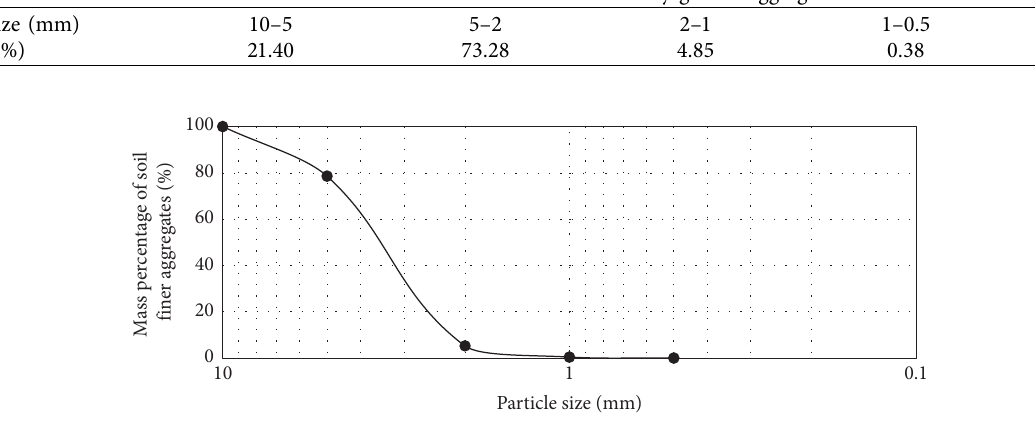
Figure 1: Particle size distribution curve of continuously graded aggregates.